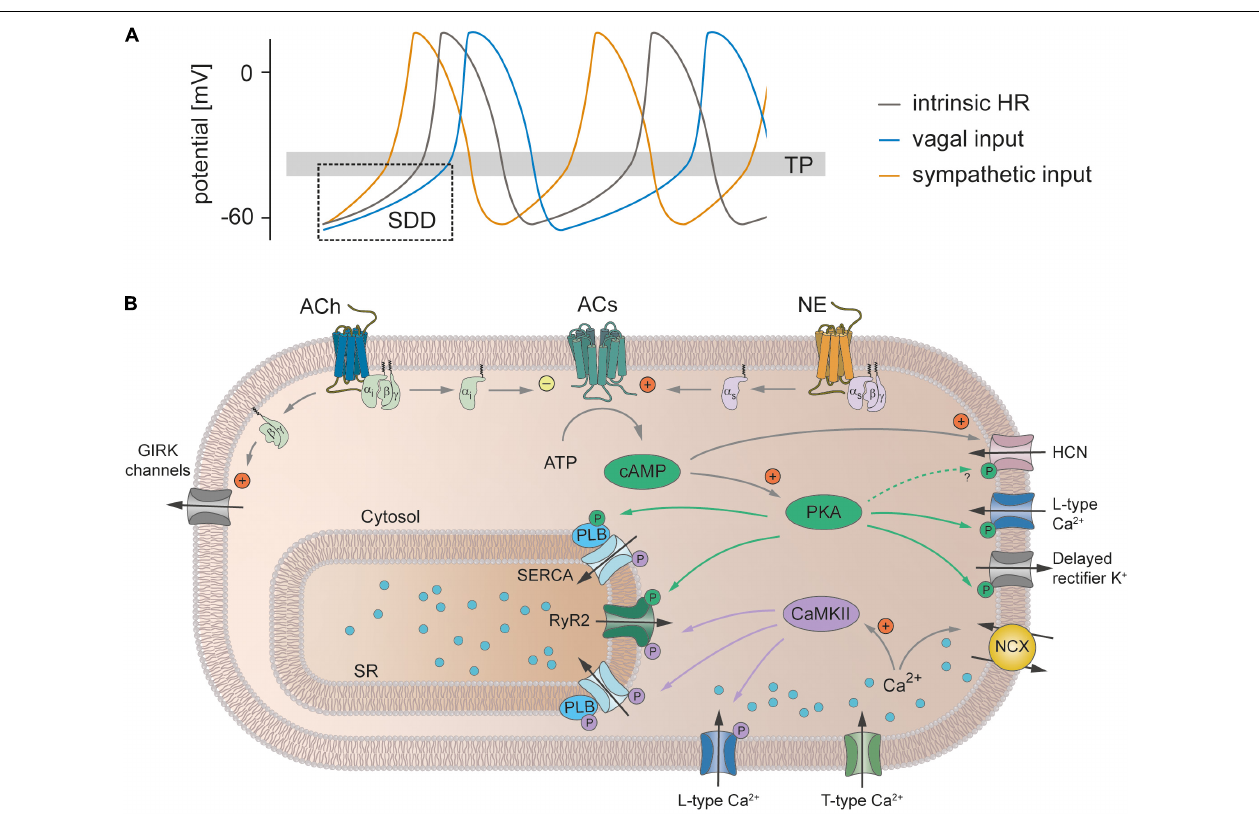
FIGURE 3 | Heart rate regulation by the autonomic nervous system. (A) SAN cell action potentials. The intrinsic action potential rate is depicted in gray. Activity of the sympathetic nervous system (orange) leads to a steeper SDD, decreases the time to reach the threshold potential (TP) for the next action potential thereby increasing action potential frequency and consequently also heart rate (positive chronotropic effect). Vagal input flattens SDD, lowers the maximum diastolic potential and thereby increases the time to reach the TP. Action potential frequency and hence HR decrease (negative chronotropic effect). (B) Signaling cascades underlying the chronotropic effect. Release of norepinephrine (NE) from sympathetic nerve terminals leads to activation of Gs protein-coupled β -receptors. Subsequent stimulation of adenylyl cyclases (ACs) increases the cytoplasmic concentration of cAMP. cAMP directly facilitates the opening of HCN channels and activates PKA, which in turn phosphorylates various proteins (indicated by green arrows and green circles), thereby increasing their activity. In addition, sympathetic activity increases the intracellular Ca 2 + concentration, which increases the activity of NCX and CaMKII. This in turn phosphorylates various target proteins (indicated by purple arrows and circles). Taken together, this steepens the SDD, increases the repolarization rate and thereby increases the action potential frequency (see text for further details). In contrast, the release of acetylcholine (ACh) during vagal activity leads to the activation of Gi protein-coupled M-receptors. ACs are inhibited by the Gi protein and thus the opposite effect of sympathetic activation unfolds. In addition, the β / γ -subunit activates GIRK channels that make the maximum diastolic potential more negative. Abbreviations: ACh, acetylcholine; ACs, adenylyl cyclases; ATP, adenosine triphosphate; CaMKII, Ca 2 + /calmodulin-dependent protein kinase II; GIRK, G protein-coupled inwardly rectifying potassium channels; HCN, hyperpolarization-activated cyclic nucleotide-gated cation channel; NE, norepinephrine; PKA, protein kinase A; PLB, phospholamban; RyR2, ryanodine receptor 2; SERCA, sarco-/endoplasmic reticulum Ca 2 + ATPase; SR, sarcoplasmic